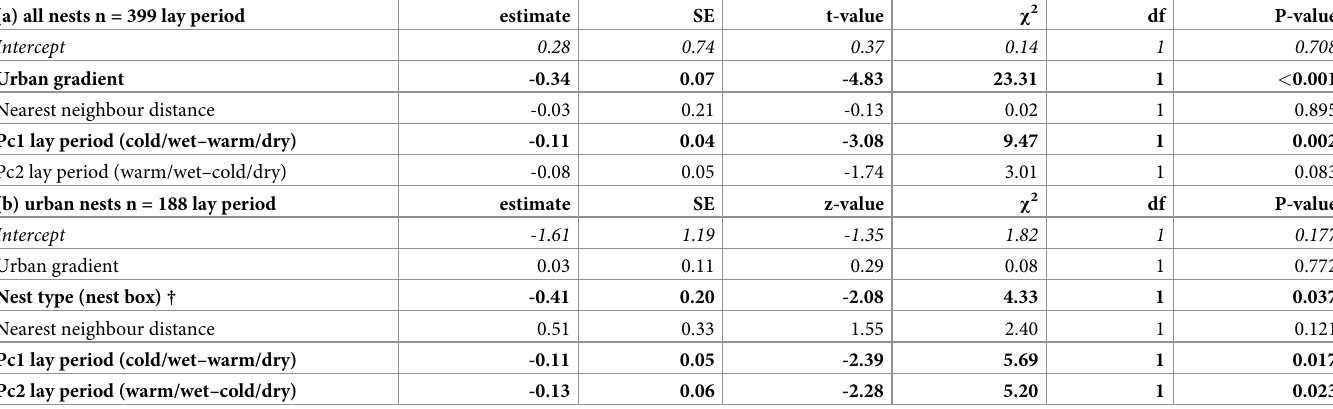
Table 2. Linear mixed effects model for the timing of breeding (lay period) in relation to (a) the urban gradient (1–78% urban cover); and (b) nest type (nest boxes versus other), nearest neighbour distance (log transformed) and weather conditions during the egg-laying period (spring). Estimated lay period of 53 and 24 peregrine territories, respectively, over 26 years (1989–2014) on the Cape